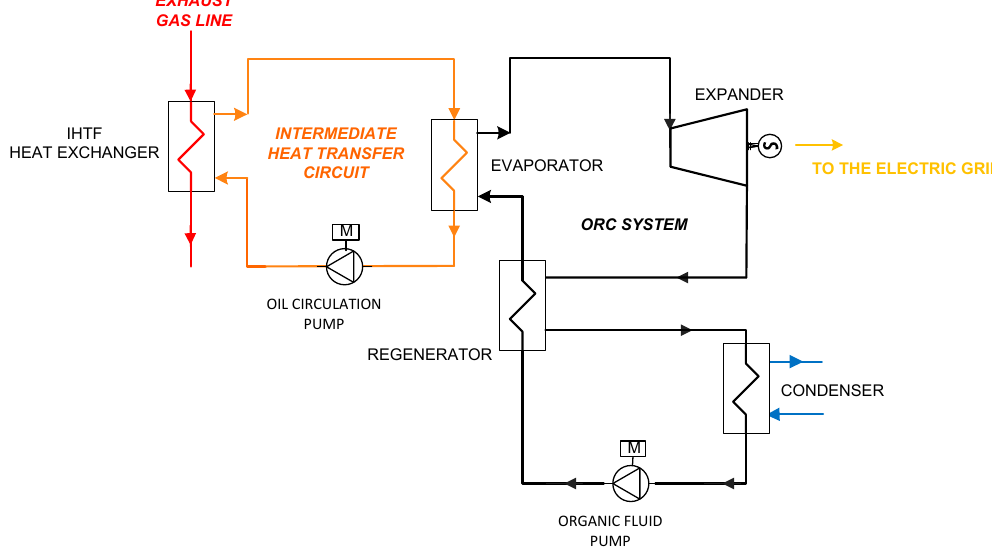
Figure 5. Schematic of the organic Rankine cycle (ORC) architecture.